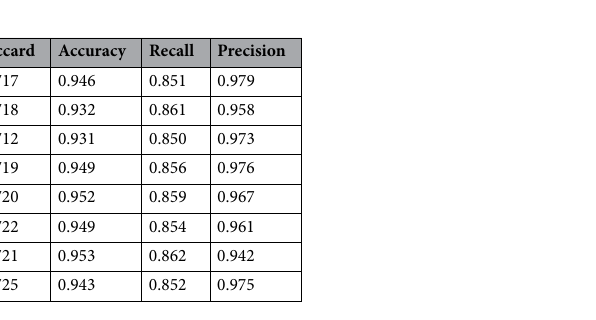
Table 2. Ablation of semi-supervised method (50 labeled / 750 unlabeled) on the testing set of Kvasir-SEG dataset. RS random scaling, GN Gaussian noise, R rotation of an image.